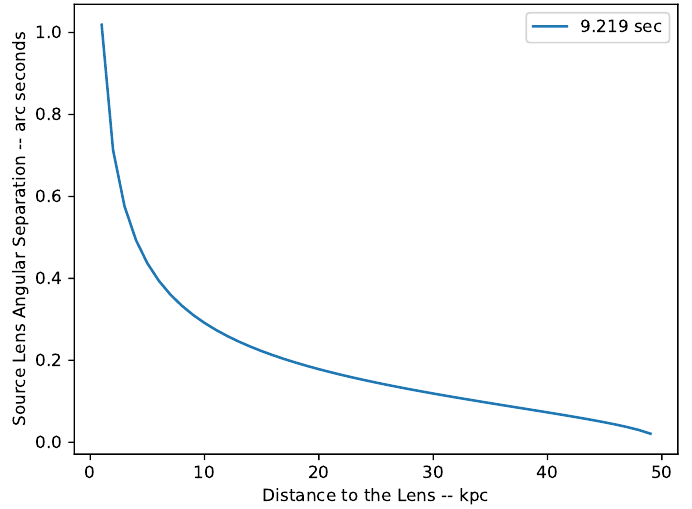
Figure 3. The angle between the lens and the source, β , in seconds of arc versus the distance to the lens for a solution for M and α 0 / β that fits the Kamiokande time and brightness